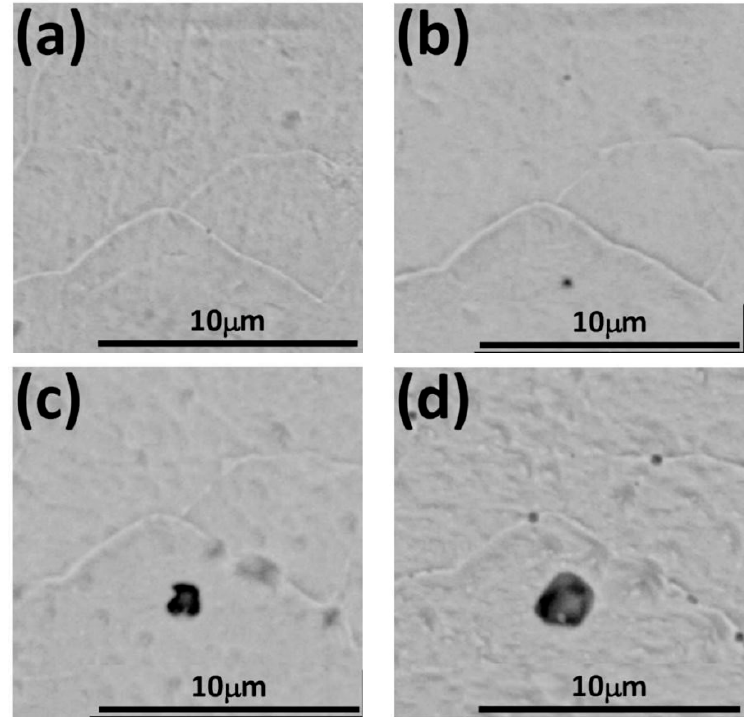
Figure 11. The surface morphology of the specimen changes: ( a ) 35 s; ( b ) 65 s; ( c ) 105 s; and ( d ) 155 s.